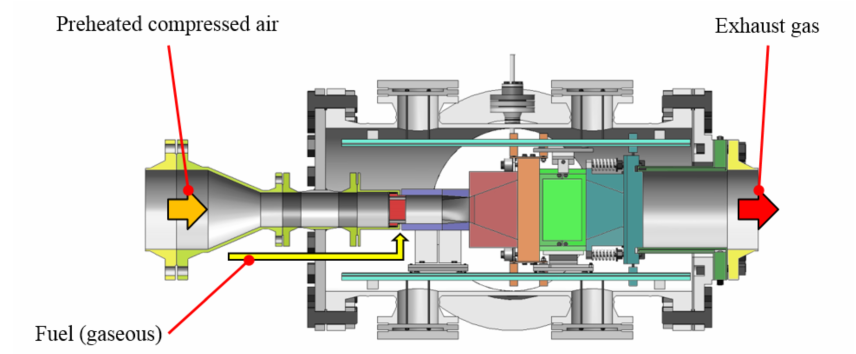
Figure 3. Axial cut of HTCTR